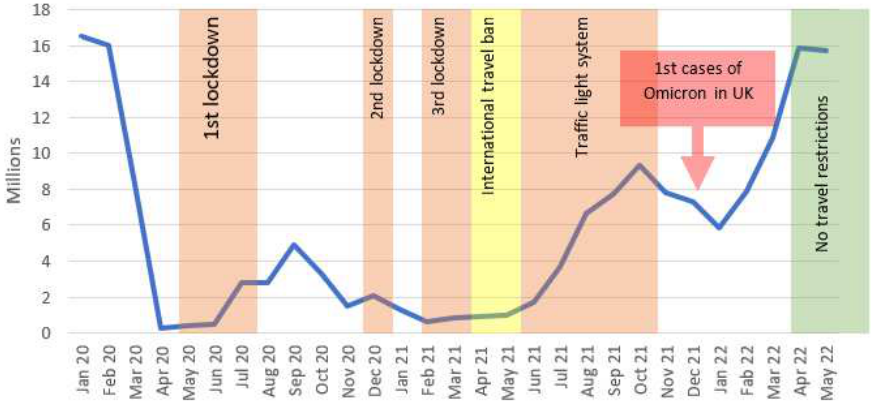
Figure 1. International passenger throughput at UK airports 20 January–22 May, drawn by the authors using data from the UK Civil Airport Authority (CAA), UK Airport Data, Table 10.1 EU and Other International Passenger Traffic [36] .